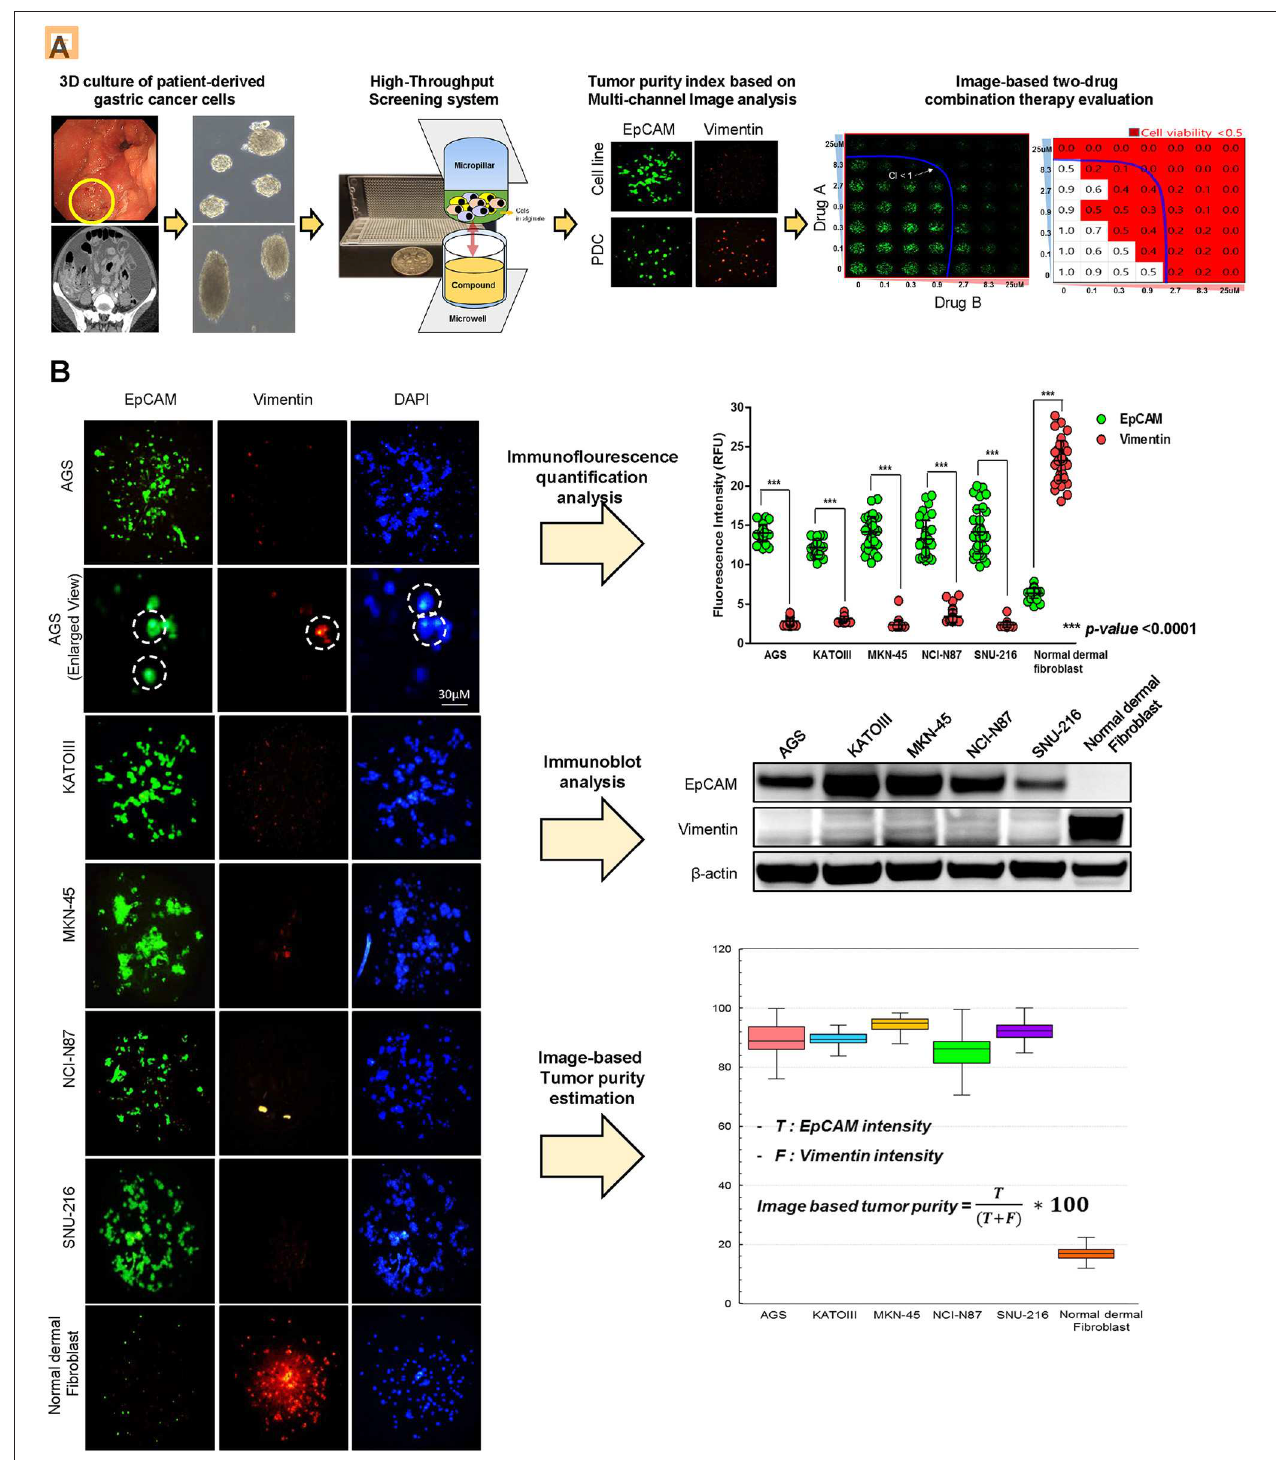
FIGURE 1 | Overview of systematic platform for prediction of tumor purity from patient tumor-derived cells (PDCs) and 3D-based high-throughput drug screening for two-drug combination therapy (A) Schematic representation of the generation of patient-derived tumor cell models from tumor tissue or malignant ascites from patients with stage IV gastric cancer. Two-dimensional (2D) cultured monolayer PDCs were seeded with 3D-culture medium. Multi-color antibodies including EpCAM, vimentin, and DAPI were used and fluorescence intensity in various gastric cancer cell lines and PDCs was measured. Tumor purity was predicted. Using PDCs with a proper amount of tumor purity, high-throughput monotherapy, or combinatorial drug screening was performed in a micropillar/microwell chip screening assay.